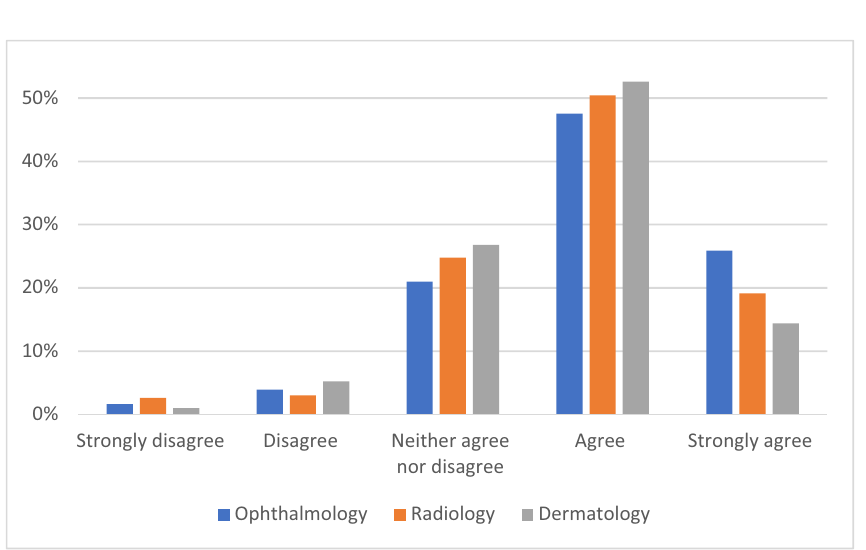
Figure 3. Levels of agreement with the statement “the field of [your specialty] will improve with the introduction of artificial